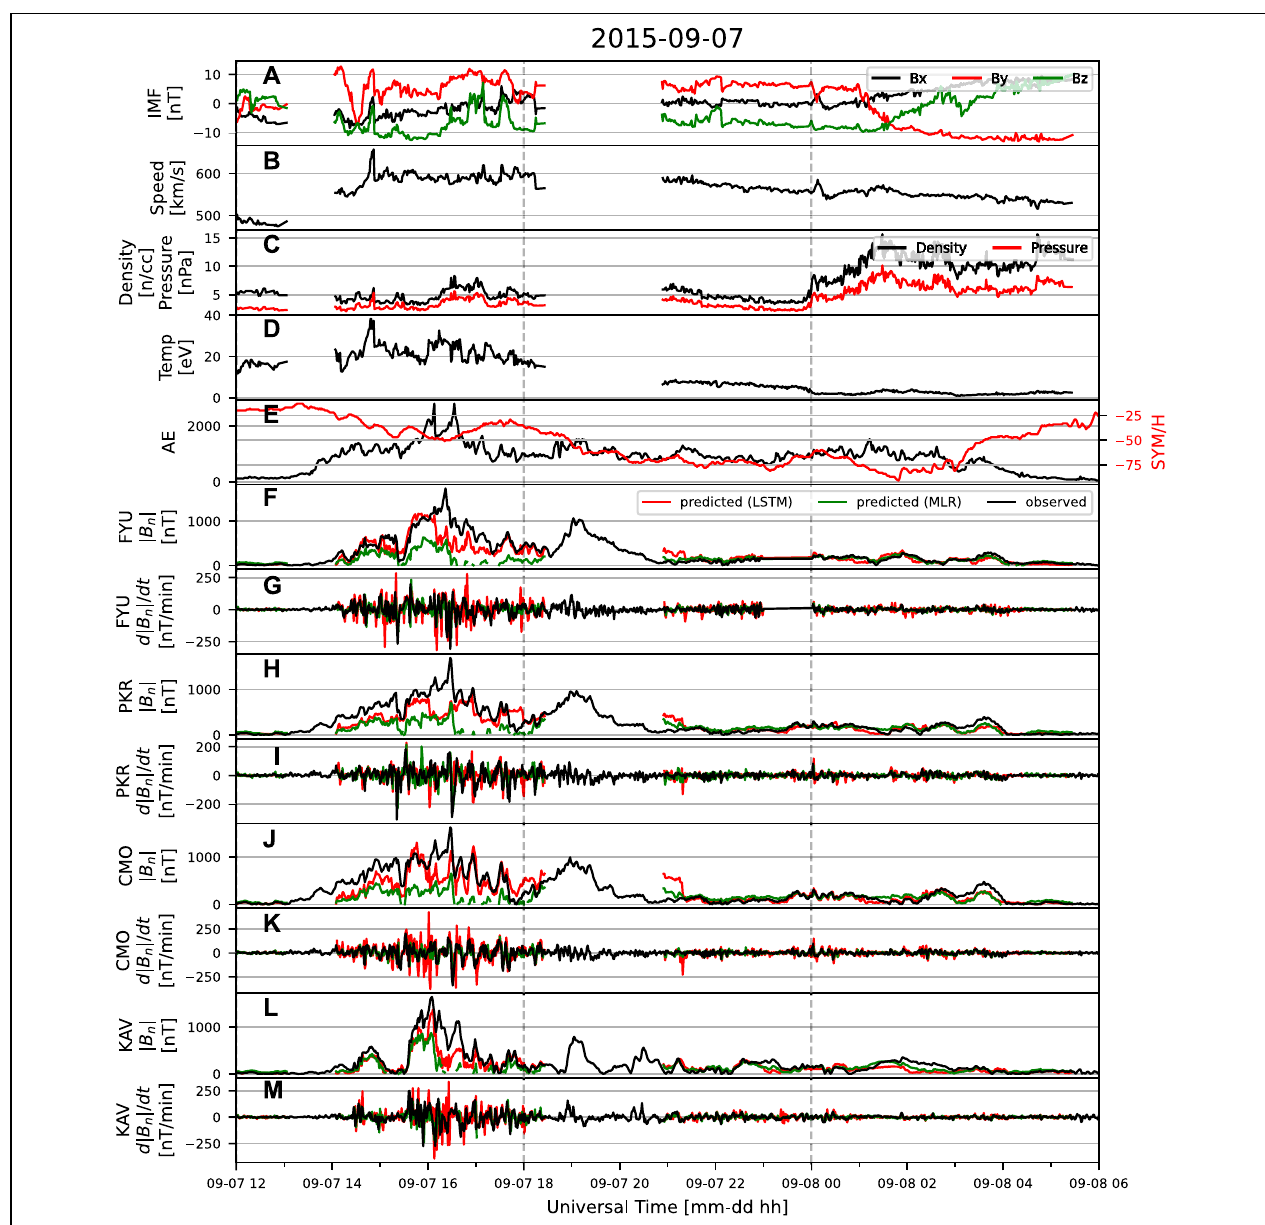
FIGURE 4 | Storm time predictions utilizing LSTM (red) and MLR (green) models showing their ability to predict the 07-Sep-2015 event for each of the 4 individual stations across Alaska. Subplots (A–E) show IMF and solar wind properties for the event while subplots (F–M) show the observed and predicted | B N | and d| B N |/dt for the four selected stations. Here we can see that for all stations the LSTM model performs better at matching | B N